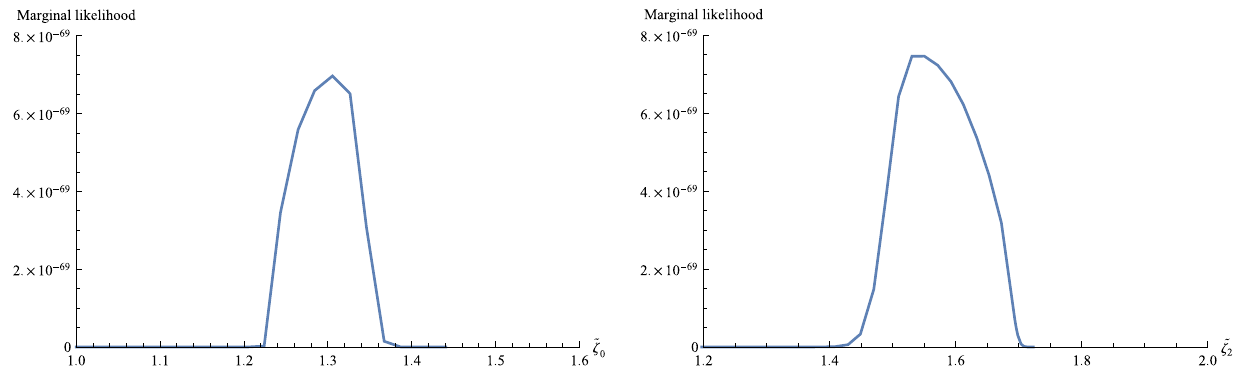
Fig. 5 Marginal likelihood of the parameters ˜ ζ 0 and ˜ ζ 2 corresponding to the case 5, when ζ = ζ 0 + ζ 2 ¨ a ˙